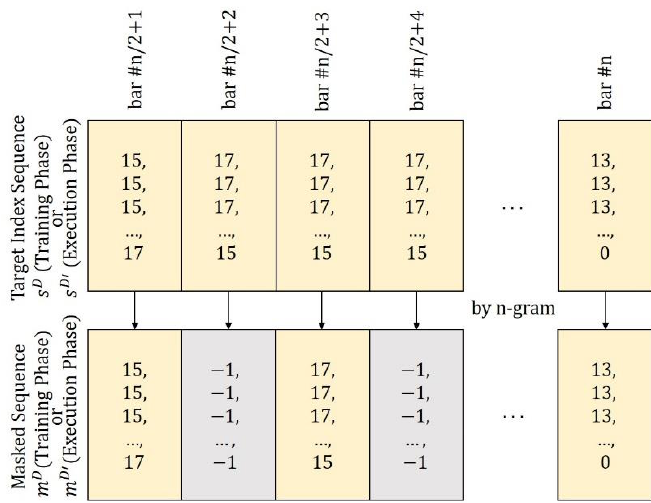
Figure 6. Masking strategy of the random masking processor.